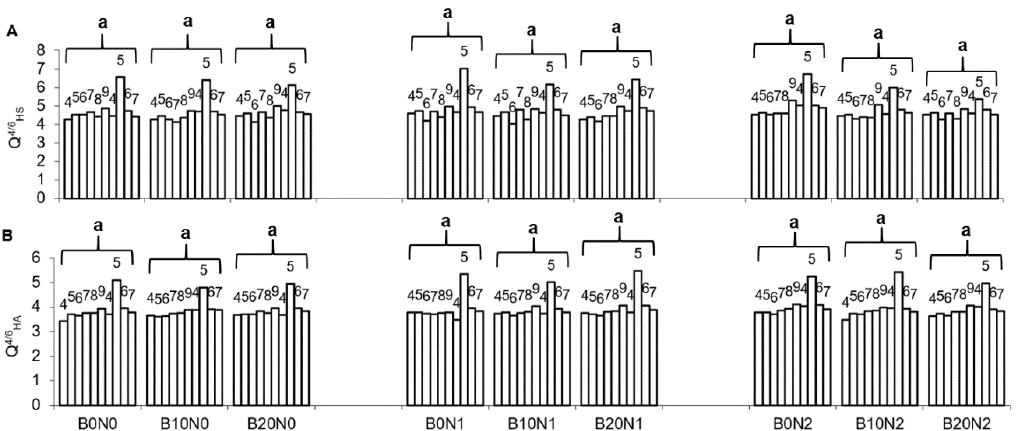
Figure 3. Dynamics of humus parameters during the vegetation season in 2017–2018: ( A ) color quotient of humus substances. ( B ) color quotient of humic acids. Treatments are mentioned in the Material and Methods Section. The vegetation season in 2017 represents April to September and in 2018, from April to July (4: April, 5: May, 6: June, 7: July, 8: August, 9: September). Different letters (a, b, c) indicate that treatment means are significantly different at p ≤ 0.05 according to the LSD multiple- range test.